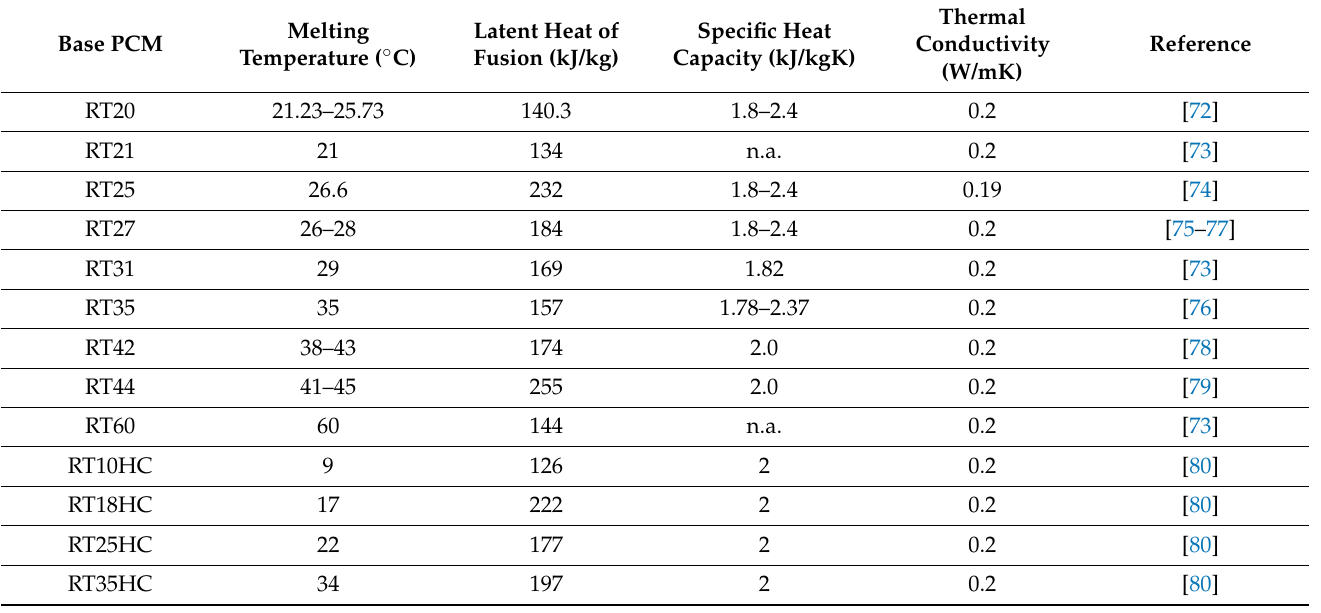
Table 1. Properties of the commonly used paraffin wax-based PCMs for solar energy